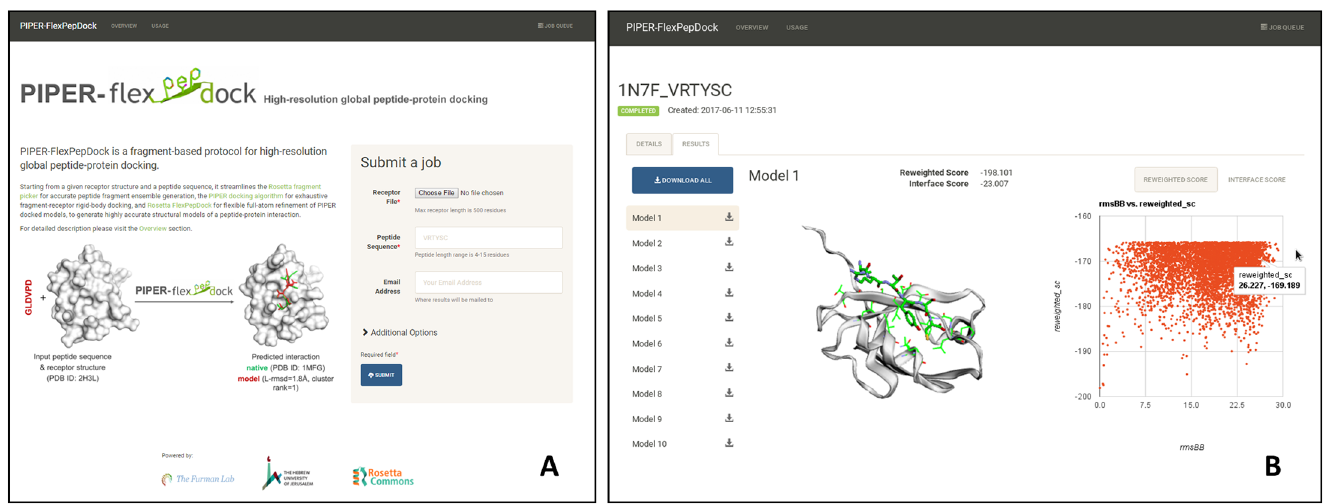
Fig 5. The PIPER-FlexPepDock server. (A) Job submission page: the required input includes the structure of the receptor and the sequence of the peptide; advanced options are accessible via a button. The tabs at the top provide links to detailed descriptions of the server, as well as to the Queue (upper right). (B) Results of an example peptide docking run: The liprin C-terminal peptide sequence VRTYSC docked onto the PDZ domain of GRIP1 (free receptor PDB id 1N7E). The top10 ranking models can be downloaded, and links to the individual models are provided to the left for inspection using an interactive viewer. In this case, Model 1 is an accurate prediction (L-RMSD = 1.0 Å from solved structure PDB id 1N7F). On the right side a scatter plot shows the sampled energy landscape (relative to the lowest energy structure of the simulation).